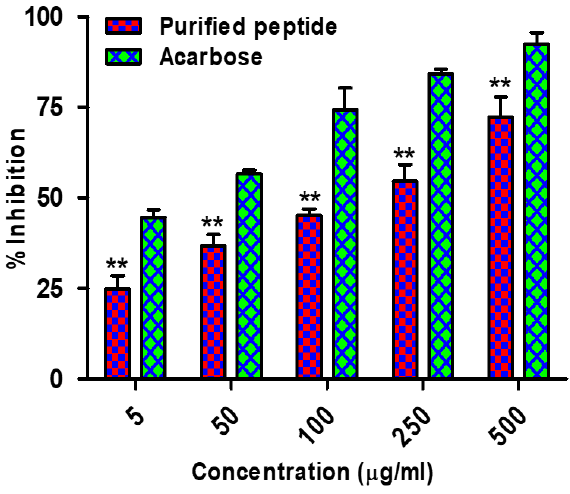
Figure 15. Inhibitory effects of chickpea peptide against α -glucosidase. ** significantly different from each other ( p < 0.05).